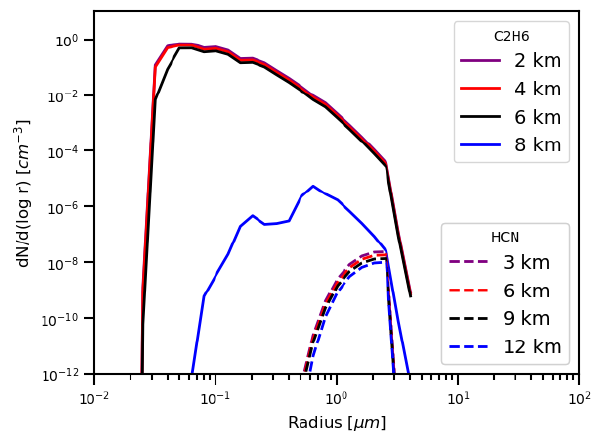
Figure 7. Size distribution of the ethane ice particles formed at the New Horizons entry site. At the altitudes where clouds begin to form, temperatures are warm enough to see both a nucleation and growth mode to the particle sizes. Closer to the surface, further condensation becomes less efficient. Dashed lines show the size distribution of the HCN ice particles. While nucleation onto pre-existing haze particles can occur, the cold temperatures result in condensation timescales longer than the age of the solar sytem. The resulting HCN ice particle sizes are therefore determined by the size of the haze nuclei and do not show further growth through condensation as they do in Titan’s atmosphere. Additionally, HCN only nucleates onto the largest haze